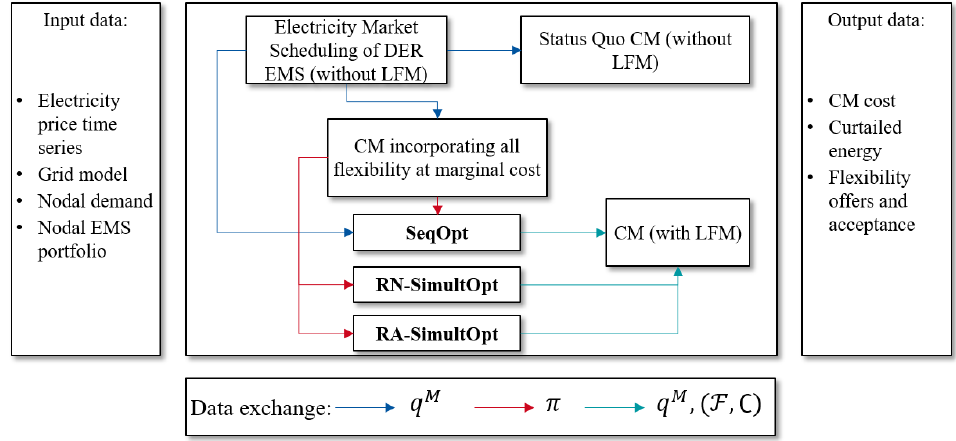
Figure 8. Overview on model interconnections in modeling